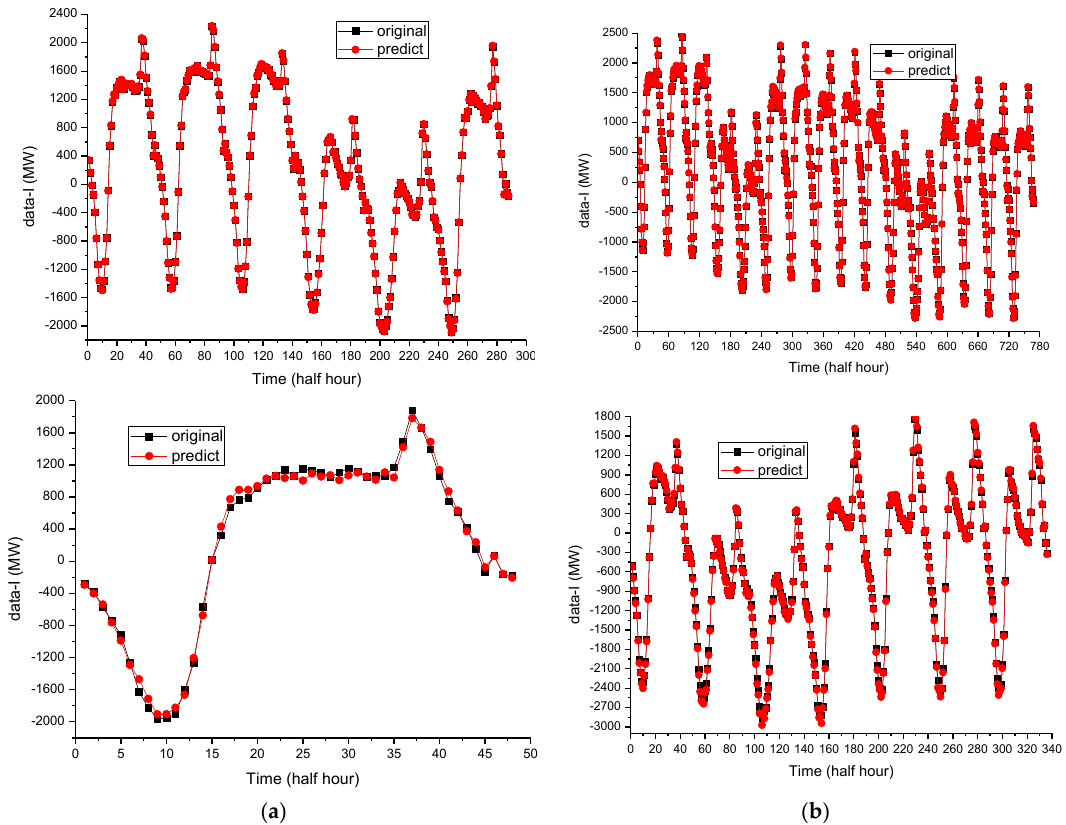
Figure 4. Comparison the forecasted electric load of train and test by the QPSO-SVR model for the data-I of sample data: ( a ) One-day ahead prediction of May 8, 2007 are performed by the model; ( b ) One-week ahead prediction from May 18, 2007 May 24, 2007 are performed by the model. Table 1. The QPSO’s parameters for SVR in Data-I.